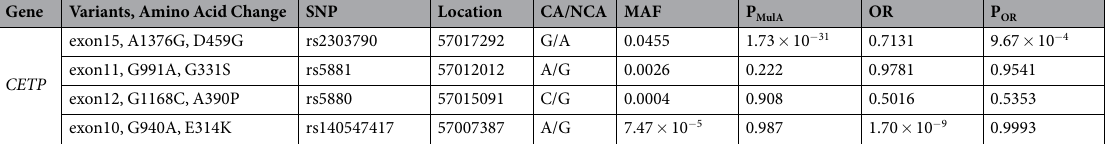
Table 3. Association of the four observed CETP rare variants with MetS in the discovery stage. SNP, single nucleotide polymorphism; MAF, minor allele frequency; PMulA, P for multivariate